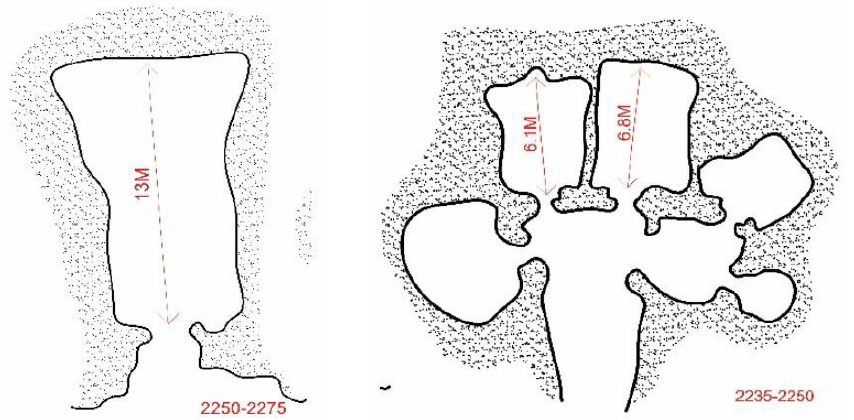
Figure 28. The difference in plan between the houses in the highest level (2250–2275) and those in the lower levels (2235–2250) from the sea level and increasing the area of rooms by increasing their depth.